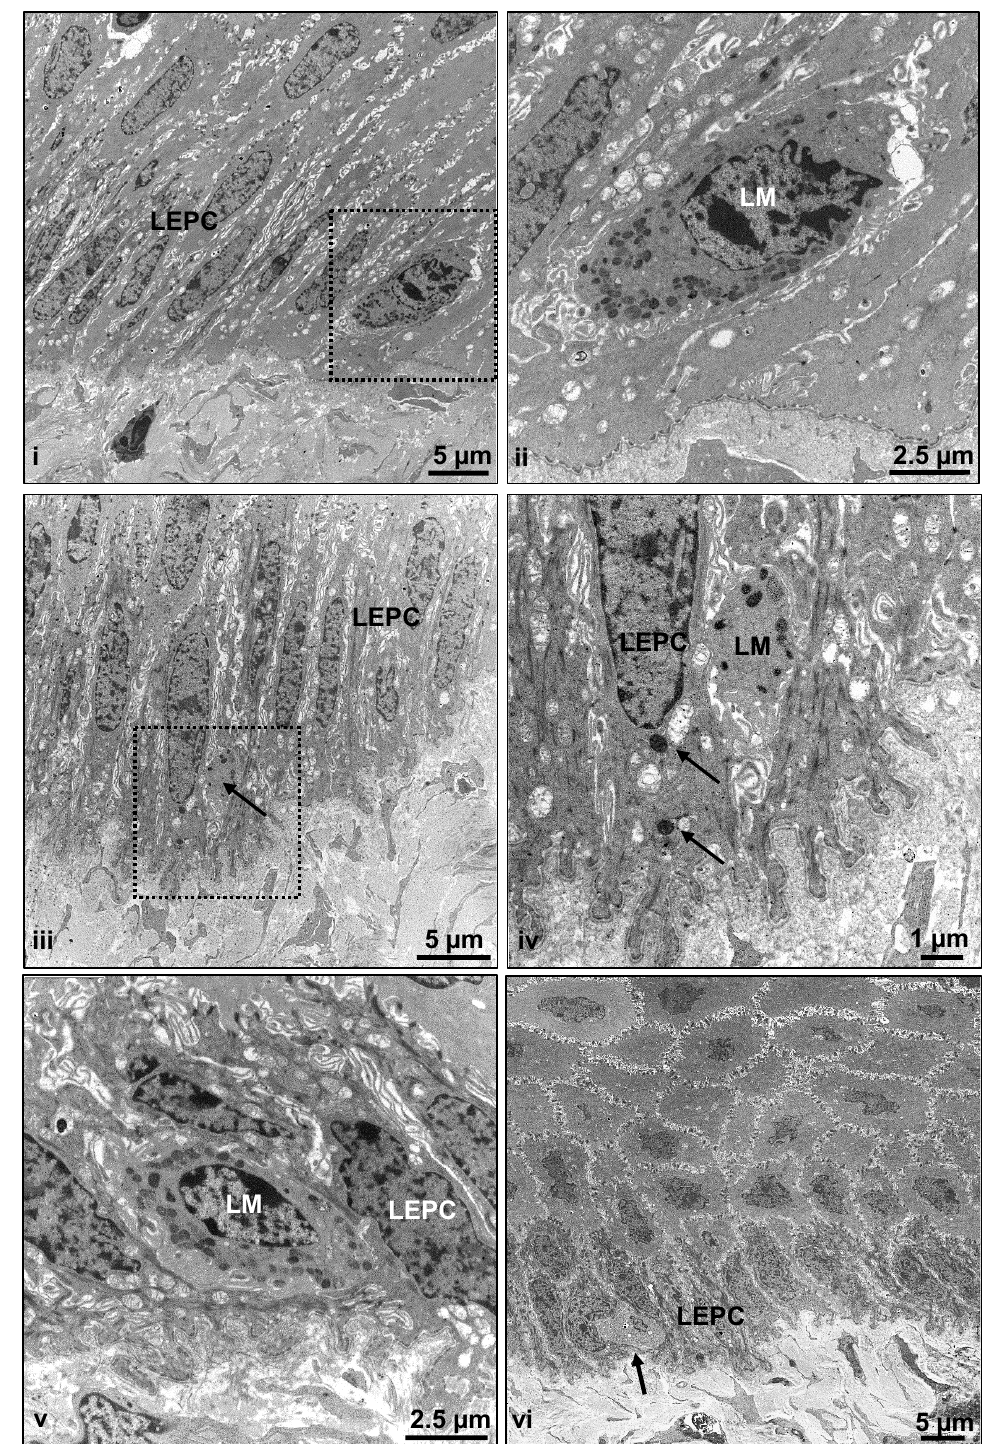
Figure 8. Electron microscopy analysis of limbal melanocytes: Transmission electron micrographs showing basal limbal epithelial cells (LEPC) in association with limbal melanocytes (LM) at the corneo-limbal transition zone ( i (recatangle), ii ) and limbal palisade zone ( iii (arrow in the recatangle showing the melanocyte) – v ); melanosomes within LEPC are shown in ( iv ) (arrows); atypical cells in the basal layer of limbal epithelium assuming atypical melanocytes (arrow, ( vi )).